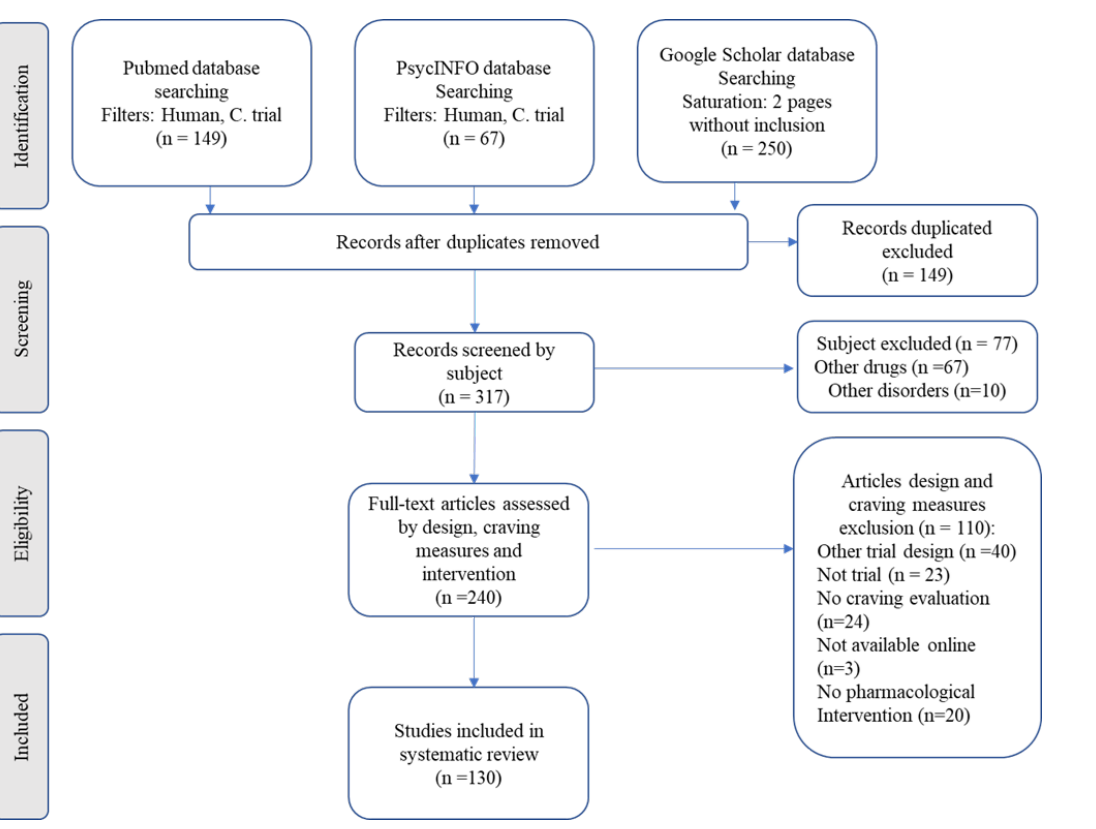
Figure 1. Preferred Reporting Items for Systematic Reviews and Meta-Analyses (PRISMA) Flow Diagram.